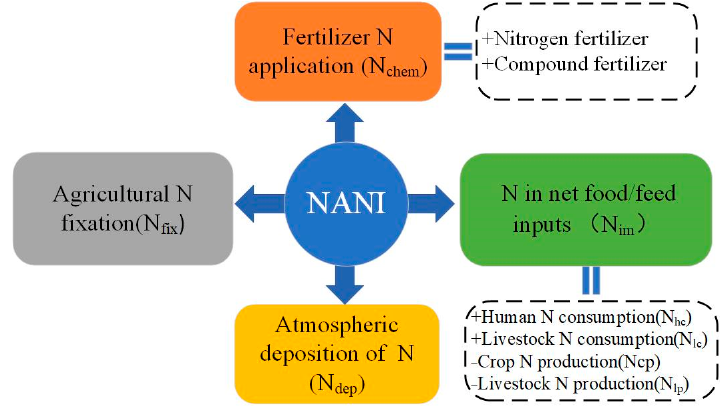
Figure 2. Methodology of the estimating of the the NANI.